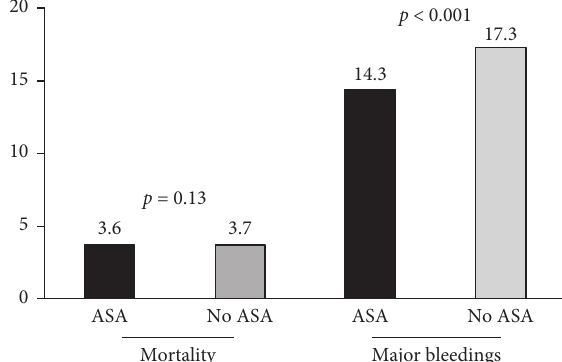
Figure 4: Bar graph showing the rate of major clinical events (mortality and major bleedings) with ASA-free or traditional dual antiplatelet strategy (DAPT) in patients receiving concomitant oral